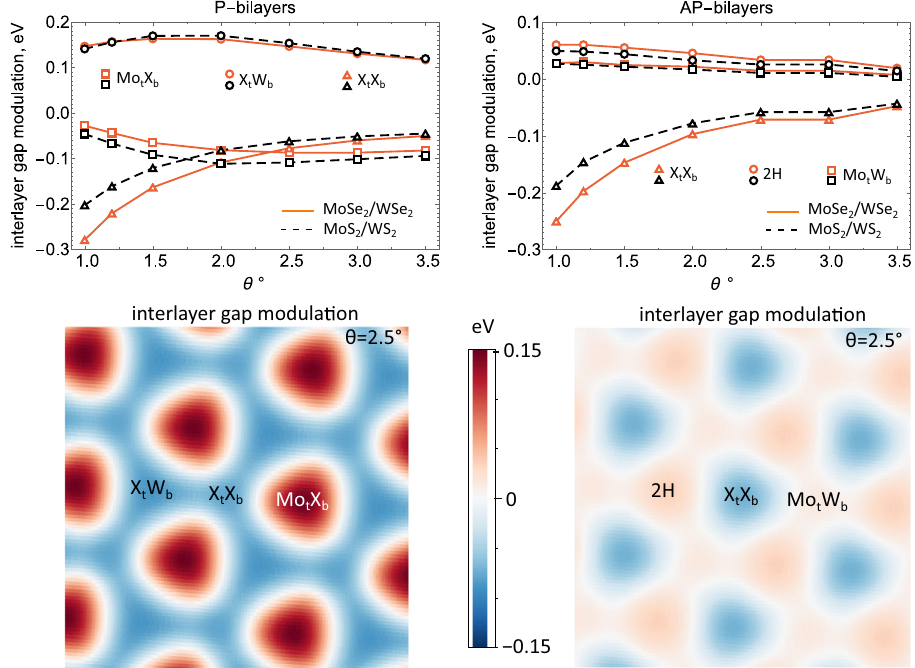
Fig. 4 (Top) Twist-angle-dependences of interlayer band gap at K-valleys at high symmetry stacking areas of moiré supercells of P- and AP-MoX 2 /WX 2 bilayers with 1 ° ≤ θ ≤ 3.5°. For P-bilayers with θ ≳ 2°, we fi nd a crossover from an array of QDs located in X t X b nodes to an antidot array with shallow minima at X t W b areas and high peaks at Mo t X b areas, while for AP-bilayers there is no such transition. (Bottom) Real space maps showing crossover (toward larger misalignment) of the interlayer band gap for MoS 2 /WS 2 bilayers with θ = 2.5°: an antidot array for P-bilayers and shallow QD array for